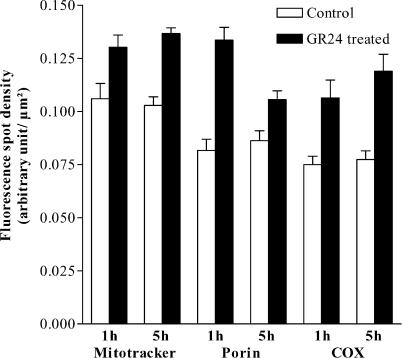
Cellular Response of Germinating Spores of
Gi. rosea to GR24 after 1 h or 5 h of Treatment with GR24
Hyphae were stained with MitoTracker Green and treated with 0.001% acetone (control) or 30 nM GR24. Mitochondrial density is significantly higher in treated samples than in control at 1 h and 5 h (
p < 0.001,
n = 26; and
p < 0.001,
n = 42, respectively). For porin and COX immunolabelling, hyphae were treated with acetone or GR24 (as above) and incubated with antibodies as described in
Materials and Methods. The fluorescence density of porin and COX immunolabelling is significantly higher in treated hyphae than in controls both at 1 h (
p < 0.001,
n = 52; and
p < 0.05,
n = 60, respectively) and at 5 h (
p < 0.05,
n = 28; and
p < 0.001,
n = 29, respectively). Error bars show SEM.